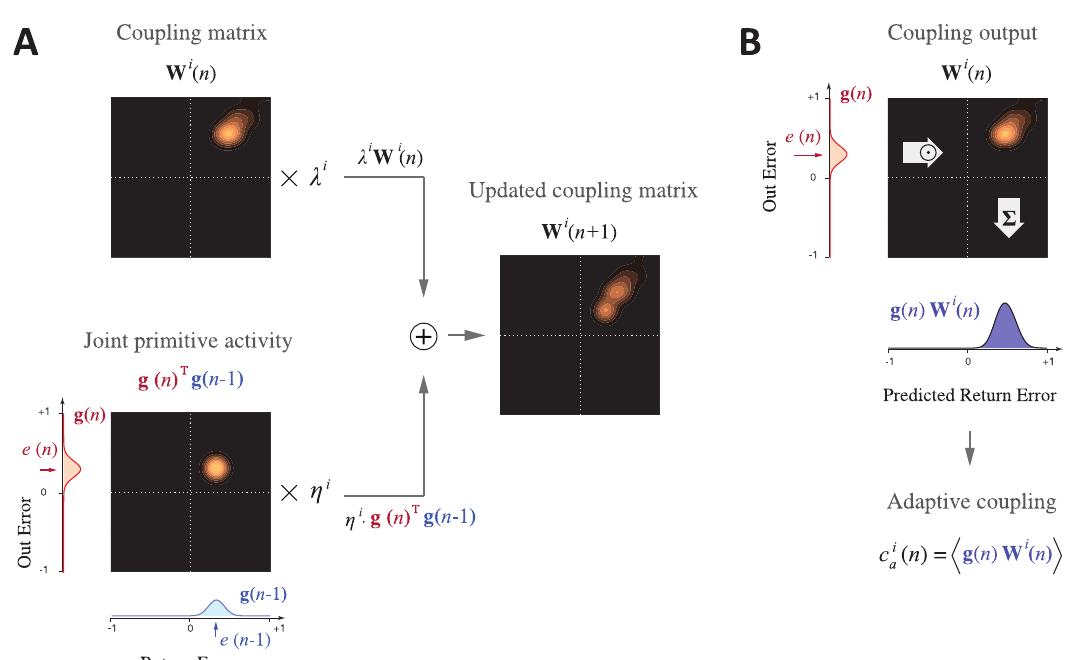
Fig 5. Model coupling. A . The update of the coupling matrix relates errors on Out and Return movements. As with the state update, the coupling matrix is updated by a combination of decay (top left) and an error-dependent accumulation process. The errors from the last two trials activate Gaussian tuning functions ( g ( n ) and g ( n − 1)) and the product gives a 2D isotropic Gaussian primitive in the coupling matrix (bottom left). The rate of decay and accumulation are determined by λ and η , respectively. There can be separate coupling matrices for the two adaptation rates. B . The final scalar coupling for a given trial is determined by multiplying the primitive for the current error by the coupling matrix and summing to determine the adaptive component of the coupling factor for that